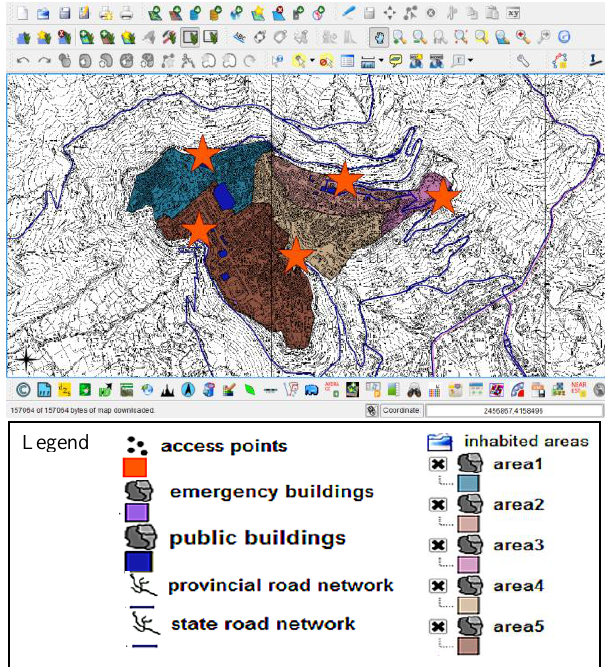
Figure 3. Classification of people exposure and points of access to the